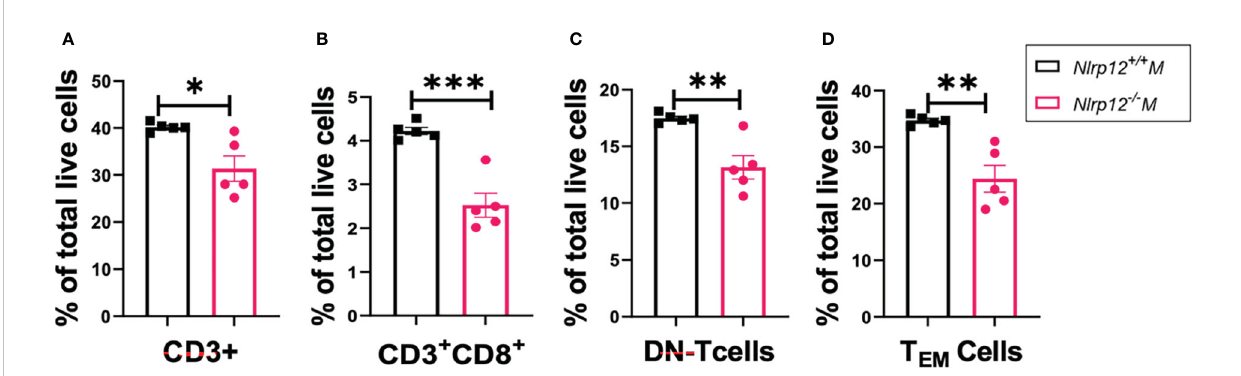
FIGURE 3 Nlrp12 de fi ciency decreases T cell expansion and responses. Spleens were harvested at the endpoint of 39 weeks of age. The percentages of total T (A) , CD8 + T (B) , DN-T (C) , and T EM (D) cells in total splenocytes as determined with fl ow cytometry are shown. Data are shown as mean ± SEM. Signi fi cant differences were determined by Student ’ s t test and shown as *P<0.05, **P<0.01, and